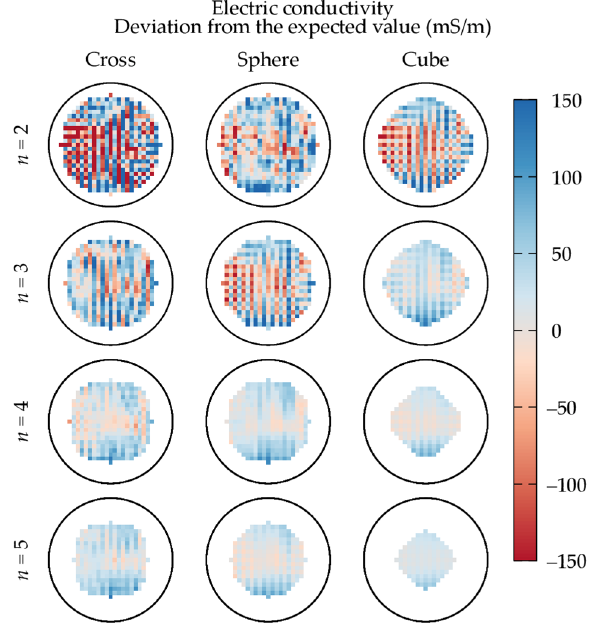
Figure 3. Relative deviation from the expected value ( σ exp = 560 mS m − 1 ) of the mean electric conductivity estimated in the scanner mid-plane by phase-based Helmholtz-EPT under repeatability conditions. The results are reported for different shapes and sizes of the kernel of the Savitzky–Golay filter. The black circle denotes the section of the sphere B p .